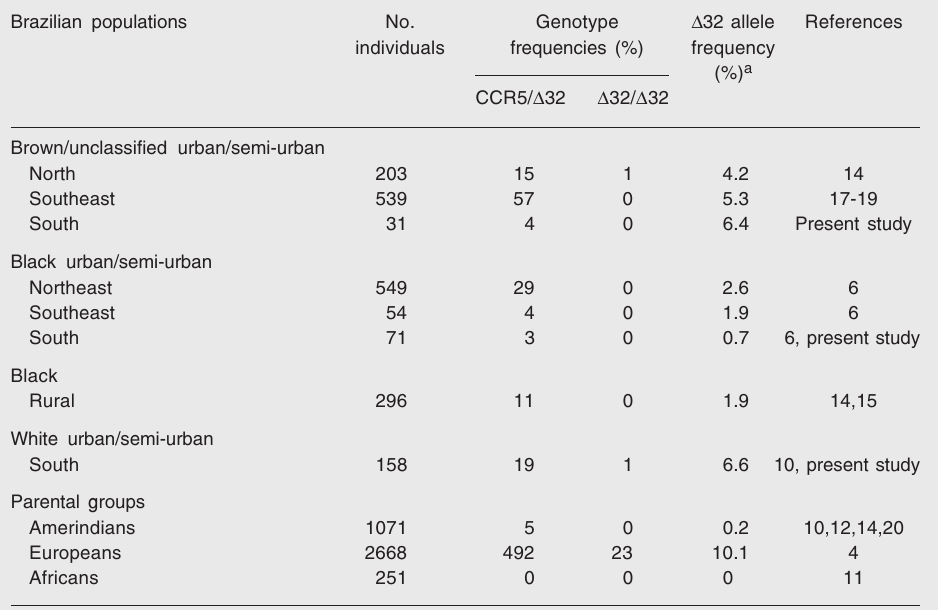
Table 1. CCR5 genotype and CCR5 ∆ 32 allele frequencies in Brazilian populations and in their putative parental groups. Brazilian populations